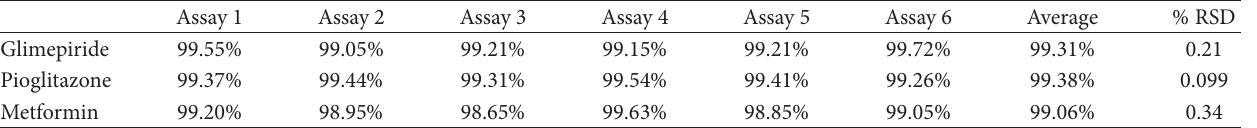
T 4: Method precision